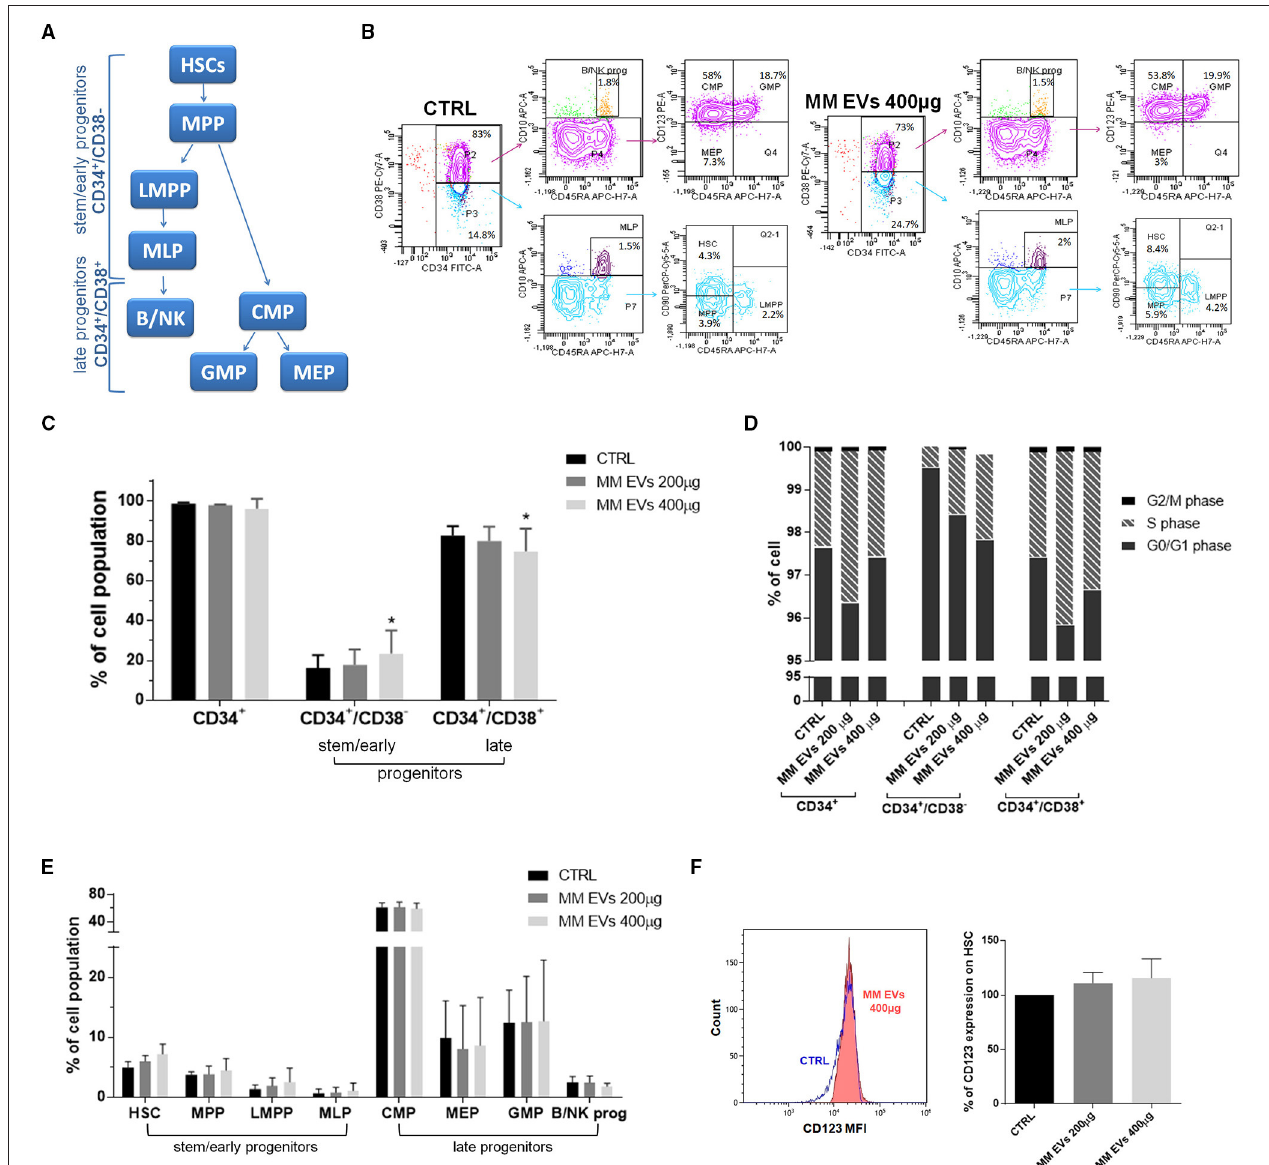
FIGURE 3 | MM-EV effect on both HSPC cell cycle and differentiation and CD123 expression on HSCs. (A) Model of human lympho-myeloid differentiation. Stem/early progenitors include hematopoietic stem cells (HSCs), multipotent progenitors (MPP), lymphoid-primed multipotent progenitor (LMPP), multi-lymphoid progenitor (MLP); late progenitors include common myeloid progenitor (CMP), megakaryocyte erythroid progenitor (MEP), granulocyte macrophage progenitor (GMP), and B/NK progenitors (B/NK prog). Arrows indicate the derivation. (B) Representative cytofluorometric dot plots of populations in HSPCs treated or not with MM-EVs for 20h. The cell percentage of each population was reported in dot plots. (C) Percentage of CD34 + , stem/early, and late progenitors after 20h of treatment with two doses of MM-EVs (MM-EVs 200 µ g, MM-EVs 400 µ g). (D) Percentage of cells in G0/G1, S, and G2/M phases on CD34 + , CD34 + /CD38 − , and CD34 + /CD38 + cells after treatment with two doses of MM-derived EVs. (E) Percentage of different HSPC populations after treatment with two doses of MM-EVs. (F) Percentage of CD123 expression on HSCs after treatment with two doses of MM-derived EVs. On the left representative histogram of CD123 mean fluorescence intensity (x-axis) in control (CTRL, blue) and treated HSPCs (MM-EVs 400 µ g, red). The bar graphs represent the average with standard deviation from three independent experiments; * indicates p = 0.05. MM, multiple myeloma; EVs, Extracellular vesicles; HSPC, hematopoietic stem and progenitor cells.